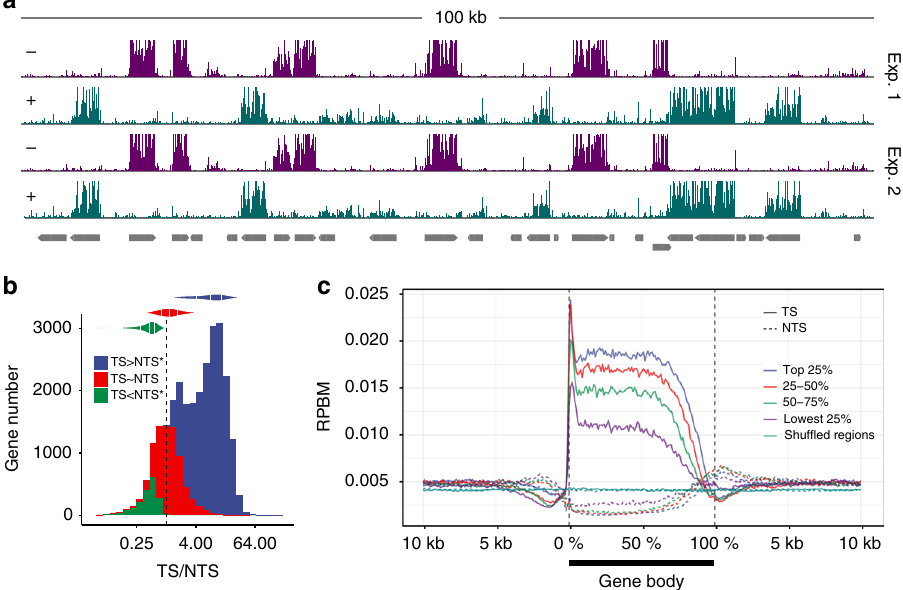
Fig. 1 Prevalence of transcription-coupled repair throughout the genome. a Strand-speci fi c XR-seq signals from two biological replicates illustrating the excision repair in the 100 kb region starting at 15,392 kb of chromosome 5. Purple and green represent plus (5 ′ to 3 ′ — left to right) and minus (5 ′ to 3 ′ — right to left) strands, respectively. Gray horizontal bars show the genes each of which has an arrow indicating its direction. b Distribution of TS/NTS repair ratios of the annotated protein-coding genes (~27,000) in histogram and violin plot format. Untransformed ratio values are shown on the log2-scaled x -axis. The vertical dashed line ( x = 1) is where TS repair is equal to NTS. Blue (TS > NTS) and green (TS < NTS) represent signi fi cant asymmetrical repair between two strands (FDR < 0.05) and red shows the remaining genes. c Repair pro fi les of the transcribed and fl anking regions of the ~9000 expressed genes. Gene body lengths are scaled to percentage and the length of each fl anking region is 10 kb divided into bins of 100 bp. The genes were grouped into quartiles based on their transcription levels. Shuf fl ed regions are the randomly repositioned genes by keeping their lengths